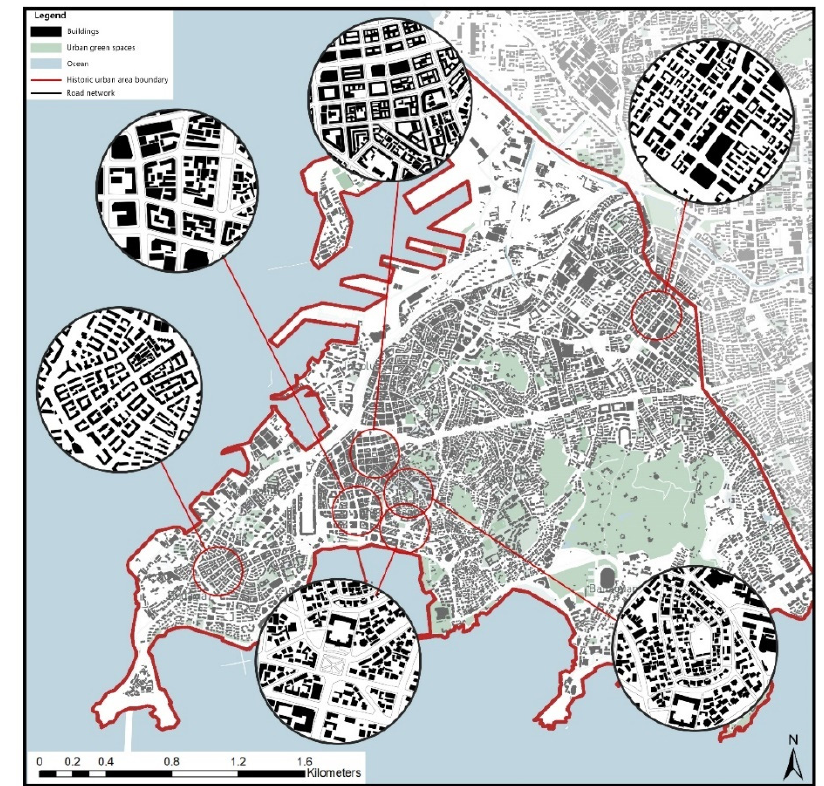
Figure 2. Urban morphology types in Qingdao historic city.